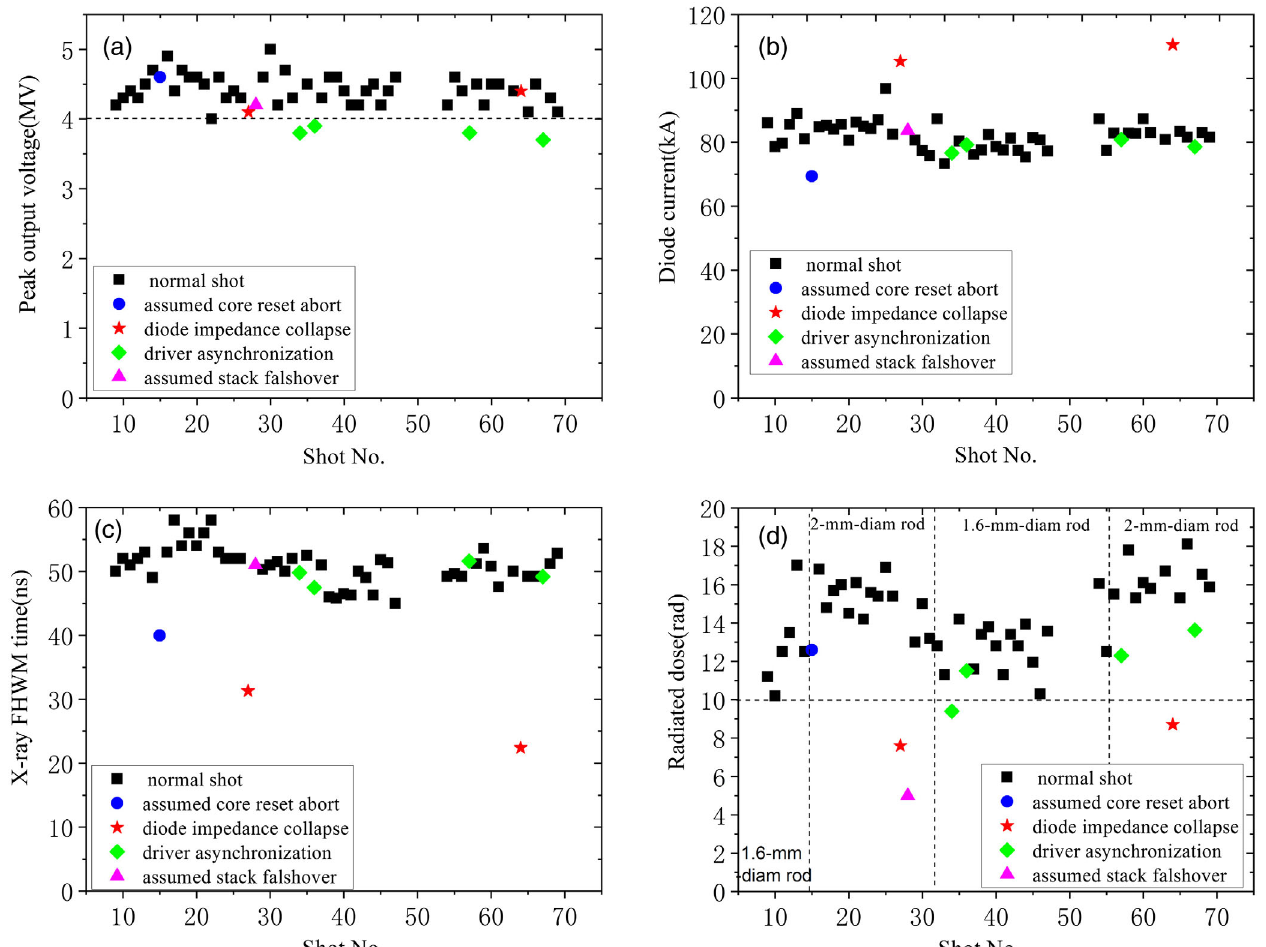
FIG. 8. Output fluctuation of the 4 MV IVA machine over 54 successive shots at (cid:1) 60 kV. (a) Peak output voltage, (b) peak diode current, (c) radiated dose, and (d) x-ray duration time. The normal shots are marked with black squares, and each malfunction mode is marked with a particular color and